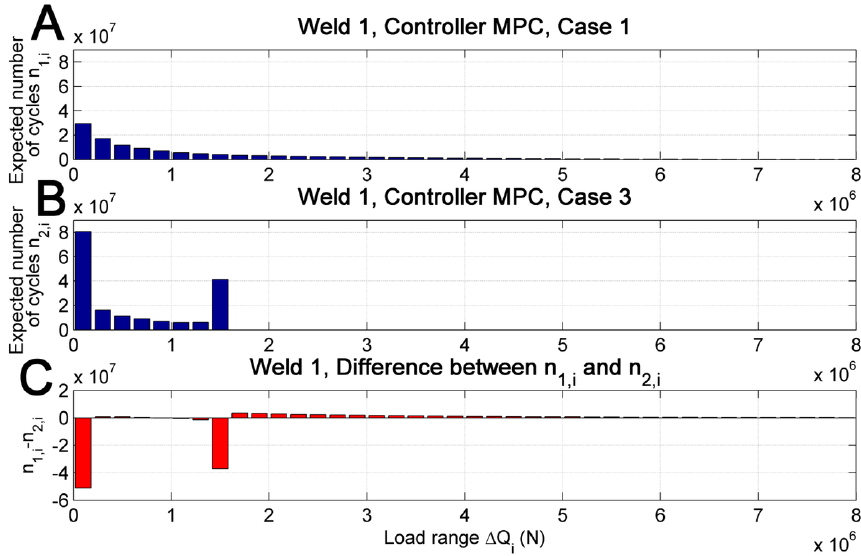
Figure 10. Expected number of cycles for a given load range during life-time of 20 years: ( A ) expected number of cycles for a given load range at Weld 1, using MPC and Case 1 (unconstraint); ( B ) expected number of cycles at Weld 1, using MPC and Case 3 (constraint); and ( C ) difference of number of cycles between A and B